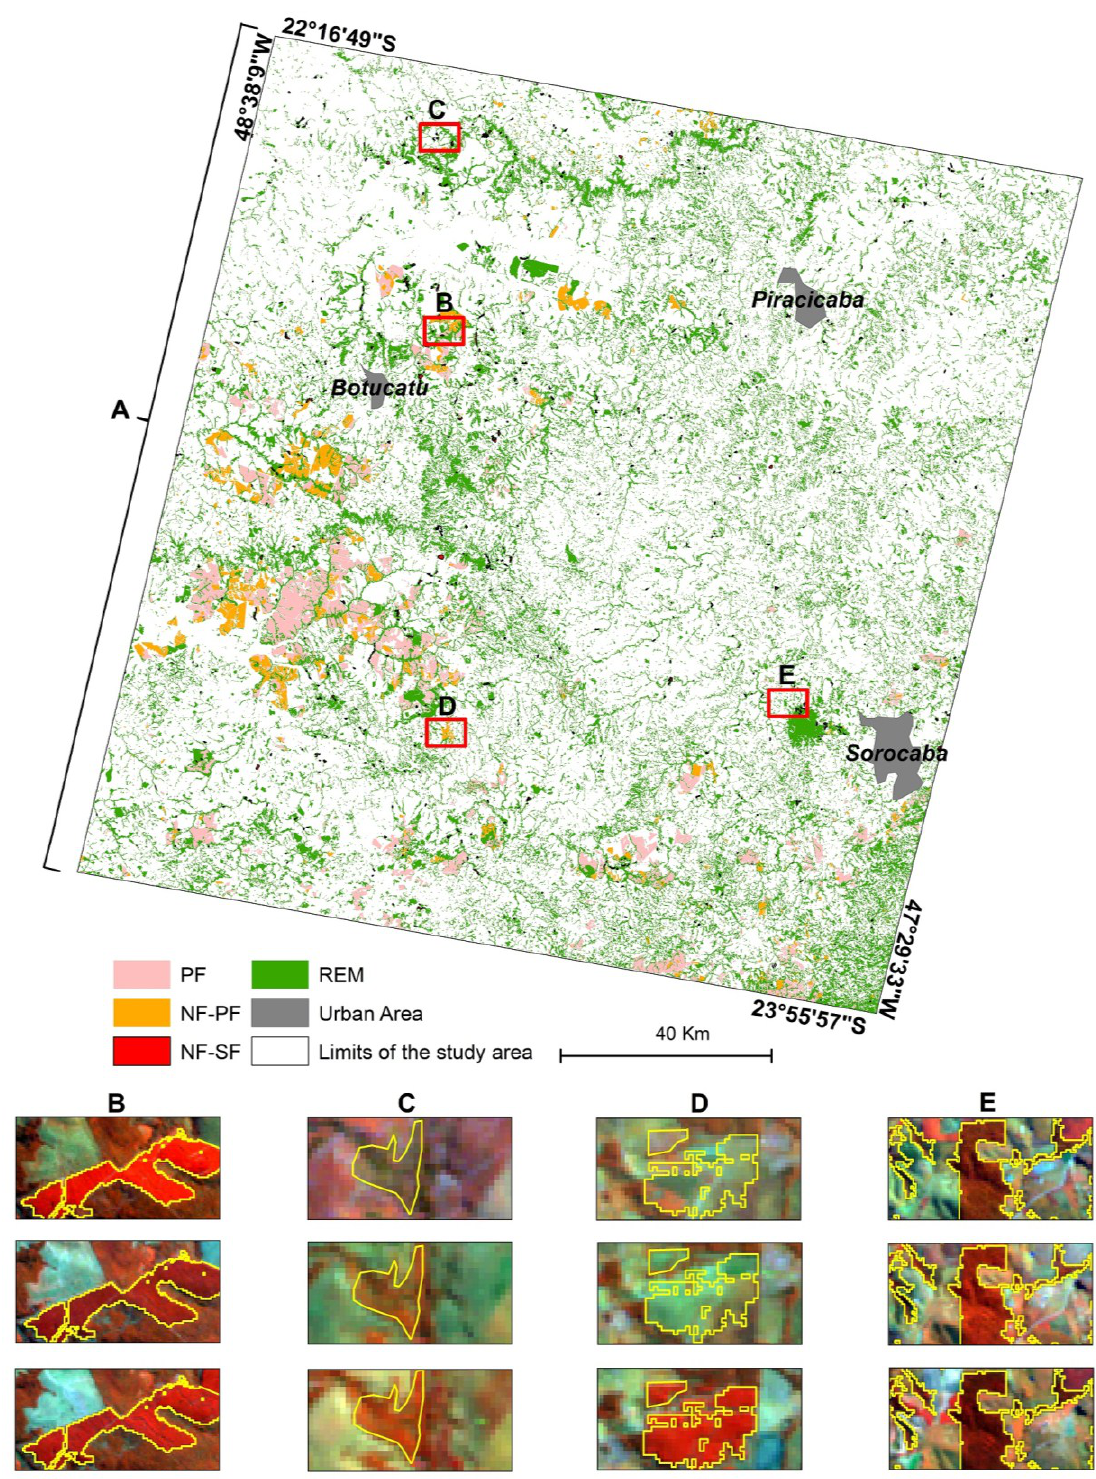
Figure 3. In ( A ) forest cover transitions map for the 1995–2005 period, with examples of: ( B ) planted forest (PF); ( C ) non-forest to secondary forest (NF-SF); ( D ) non-forest to planted forest (NF-PF); and ( E ) remnants (REM). ( B – E ) show false color composites RGB 453 of Landsat TM images from 1995, 2000, and